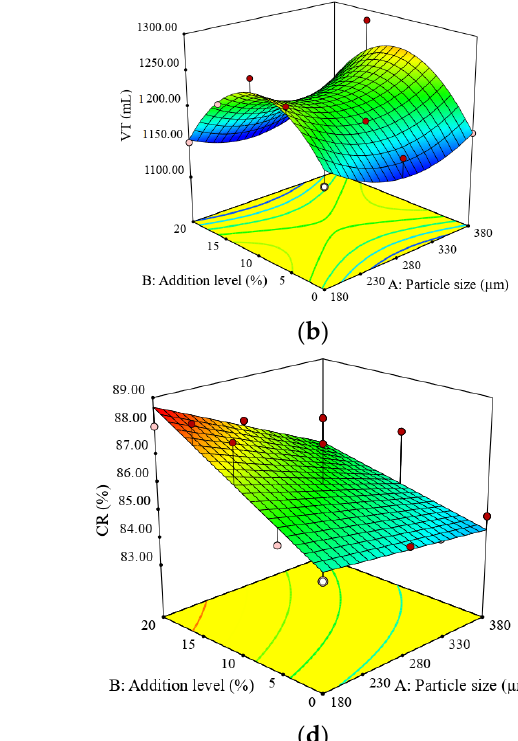
Figure 4. 3D response surface graphic presenting the effect of quinoa flour particle and addition level on: ( a ) maximum height of the gas release curve (H’m); ( b ) total CO 2 volume production (VT); ( c ) volume of the gas retained in the dough at the end of the test (VR); ( d ) retention coefficient (CR). The variation of the dynamic dough rheological parameters as a function of quinoa flour particle size, addition level, and the combined effect of the factors, at the frequency of 1 Hz, was accurately predicted by significant ( p < 0.05) mathematical models, which explained between 52 and 99% of the data variation (Table 3). Elastic, G (cid:48) and viscous, G (cid:48)(cid:48) modulus increased when the quinoa flour addition level increased, while the quinoa particle size did not present a significant effect on the dynamic modulus (Figure 5a, b).